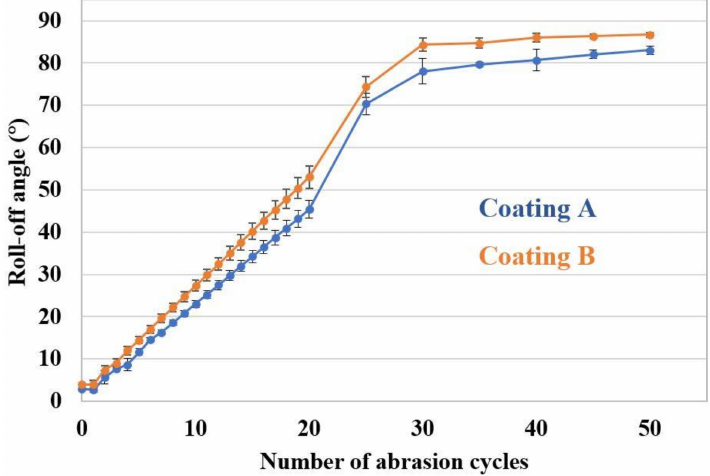
Figure 7. Roll-off angles after abrasion against a 240-grit sandpaper with 7.75 kPa normal load.